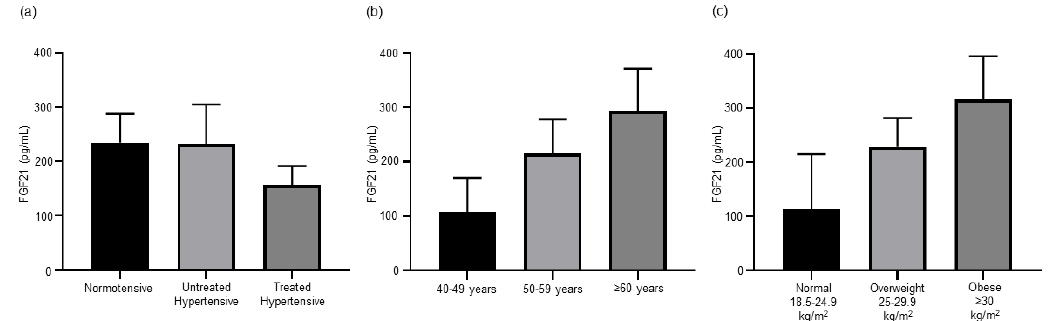
Figure 2. ( a ) Antihypertension treatments decreased the level of FGF21 in hypertensive patients ( n = 12–18). ( b ) Circulating levels of FGF21 increase with age ( n = 5–14) and ( c ) BMI ( n = 3–21). All data are presented as the mean ± SEM. FGF21, fibroblast growth factor